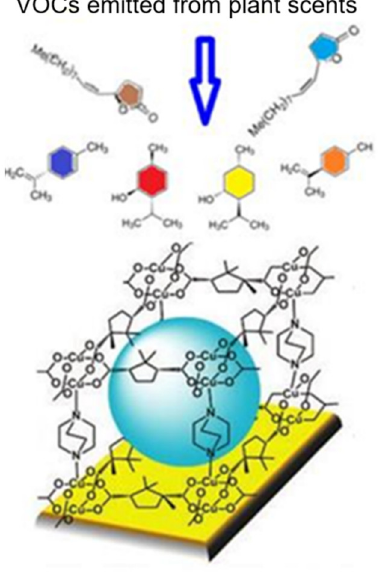
Figure 3. MOFs. Highly porous SURMOFs with huge specific surfaces coated on a QCM adsorb VOCs on the outer surface as well as inside the pores. Part of the Figure 3 was reproduced from Ref. [38] with permission from the Royal Society of